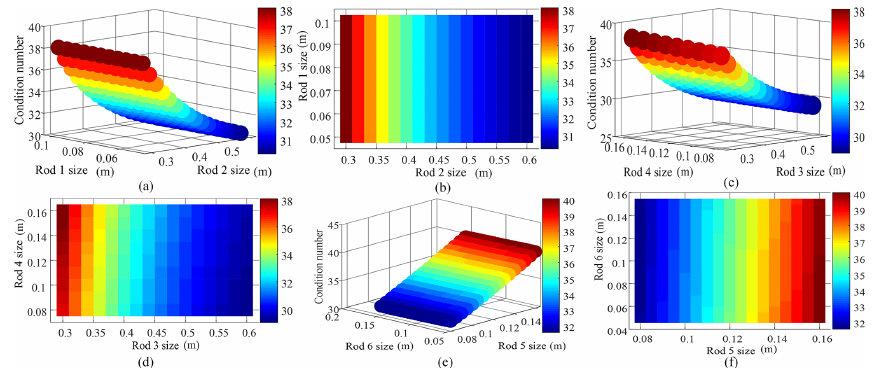
Figure 6. Effect of each link size on condition number. (a) The effect of rod 1 and rod 2. (b) Top view of the effect of rod 1 and rod 2. (c) The effect of rod 3 and rod 4. (d) Top view of the effect of rod 3 and rod 4. (e) The effect of rod 5 and rod 6. (f) Top view of the effect of rod 5 and rod